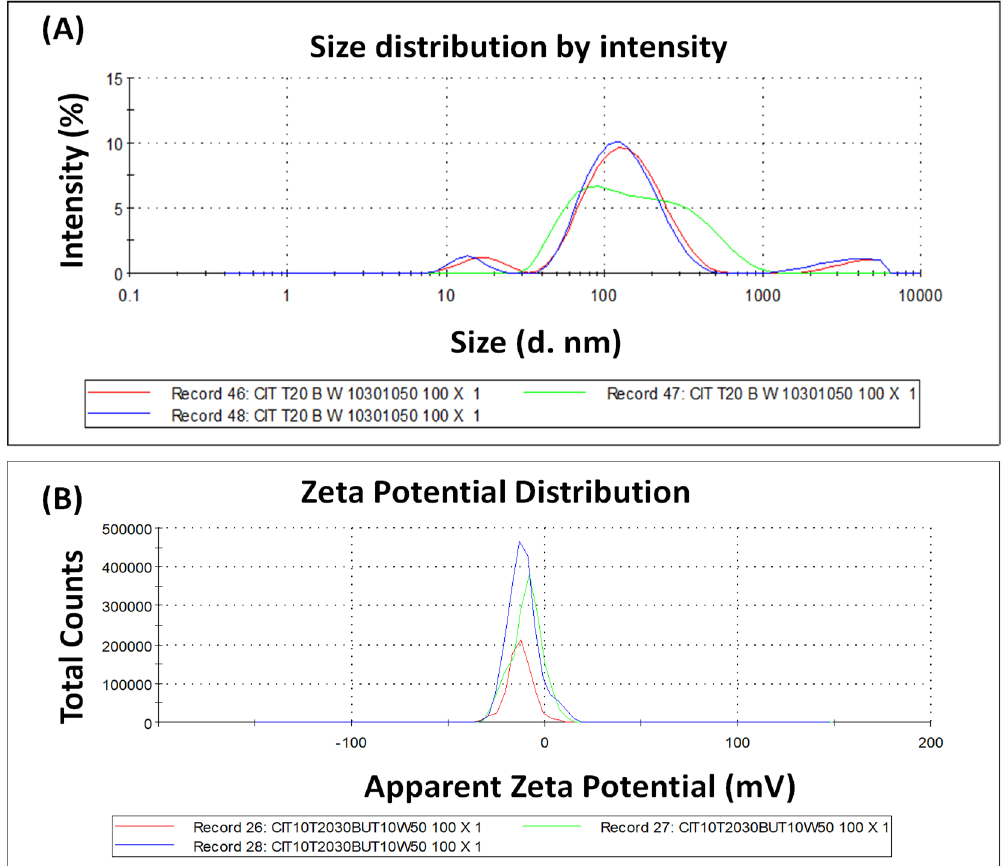
Figure 2. ( A ) Particle size and size distribution; ( B ) Zeta size of CITEO ‐ loaded nanoemulsion.